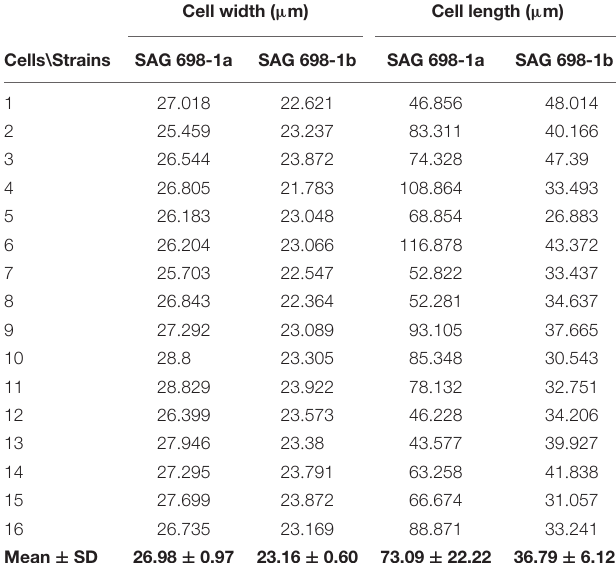
TABLE 1 | Cell sizes of SAG 698-1a and SAG